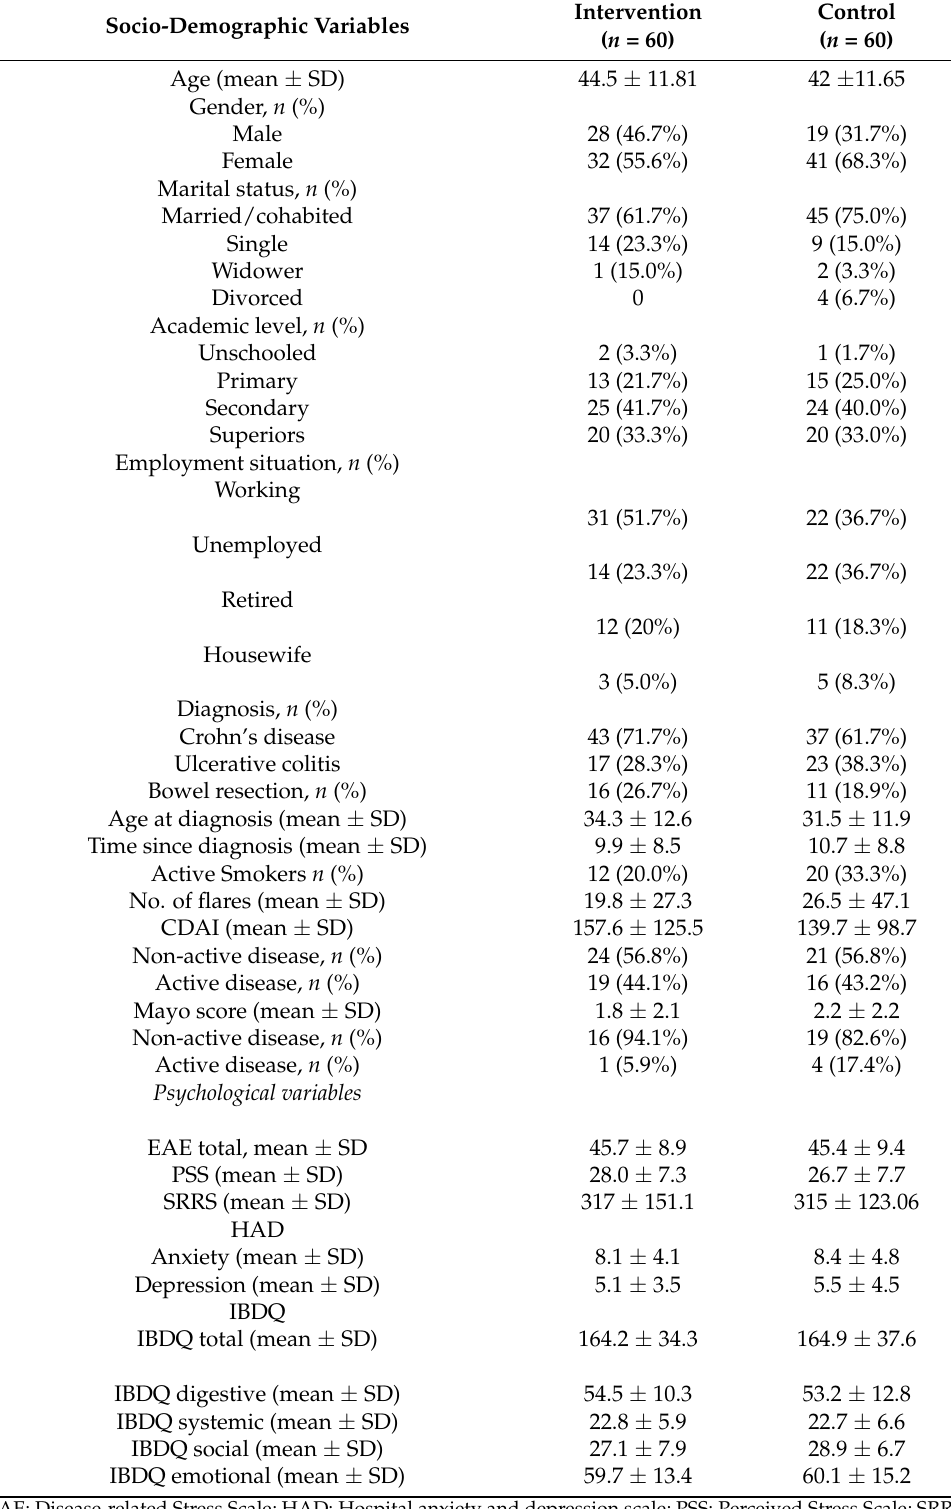
Table 1. Baseline measurements and demographic